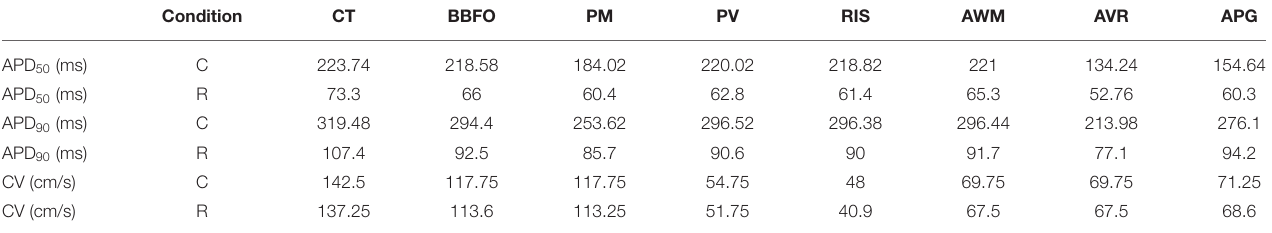
TABLE 3 | Comparison between region-specific APD 50 , APD 90 , and CV values for control (C) and remodeled (R) atria, at 37 ◦ C , from tissue simulations. Condition